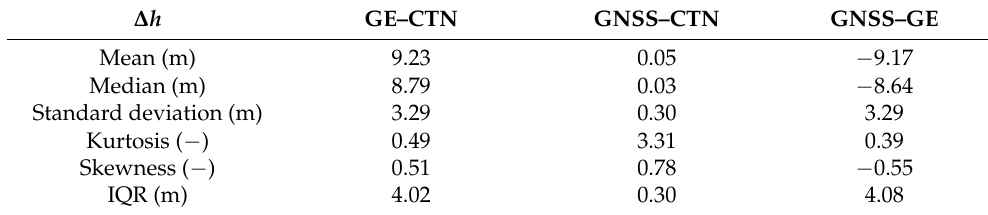
Table 1. Descriptive statistics of Δ E : mean, median, standard deviation, kurtosis, skewness, and IQR.